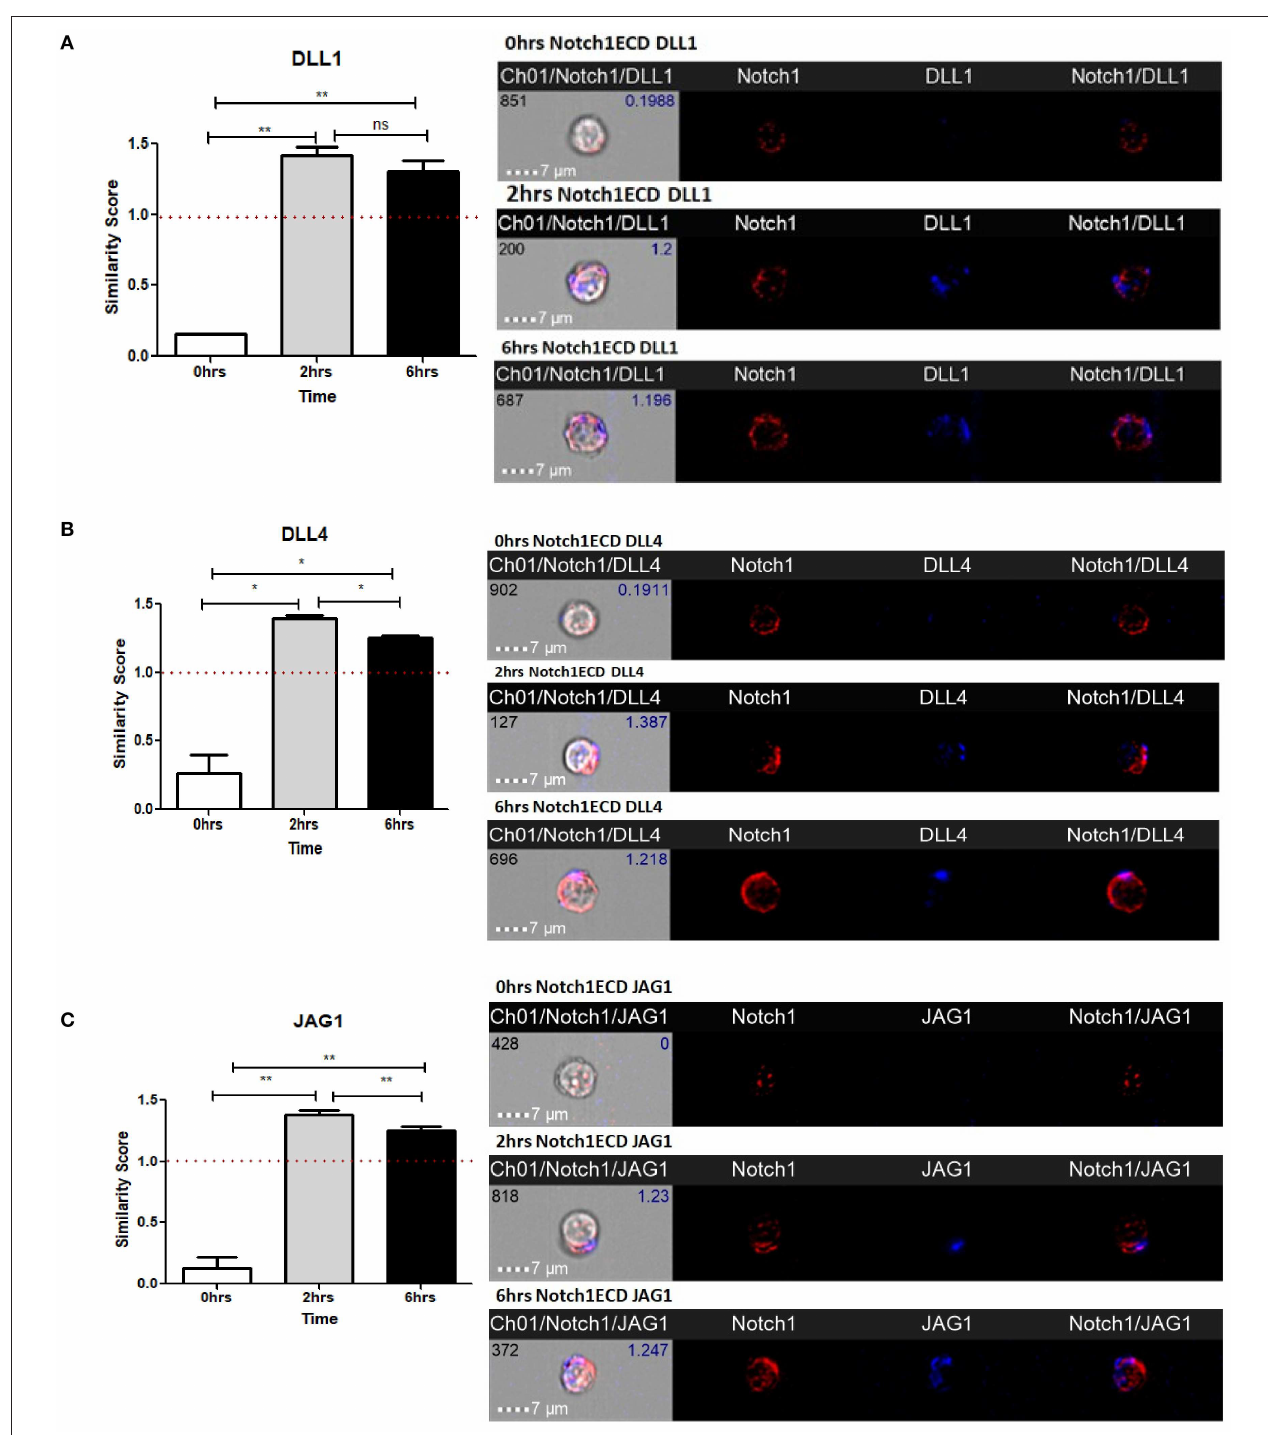
FIGURE 3 | Notch ligands expressed on CD4T cells colocalize with Notch receptor on the same cell. CD4T cells from C57BL/6 mice were treated with soluble anti-CD3 ε and anti-CD28 at 1 µ g/mL for indicated time points. Cells were harvested and analyzed by AMNIS Imaging flow cytometry. Similarity scores indicate the degree of colocalization of each ligand with Notch extracellular domain. Similarity score values were plotted along with images acquired 60 × magnification for (A) DLL1 and N1ECD, (B) DLL4 and N1ECD, and (C) JAG1 and N1ECD. Images to the right of (A–C) show expression and colocalization of each of DLL1, DLL4, JAG1 with N1ECD at time point. Data represent three independent experiments. The analysis was done by gating on live cells as determined by absence of zombie staining. Data represent mean ± SEM. * p < 0.05, ** p < 0.005. ns, not significant.